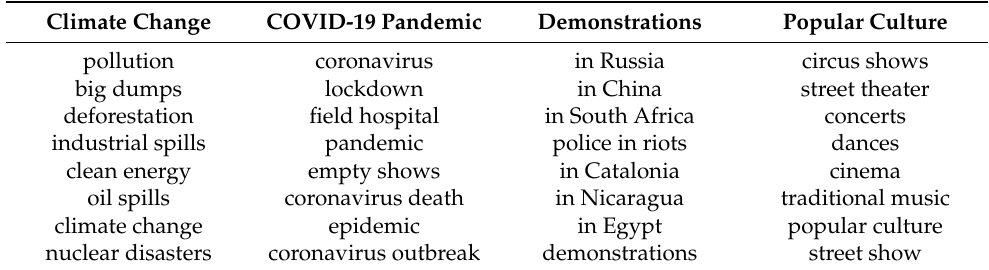
Table 1. Phrases that the artist Pilar Rosado used to retrieve from Google the 40,000 images shown in the